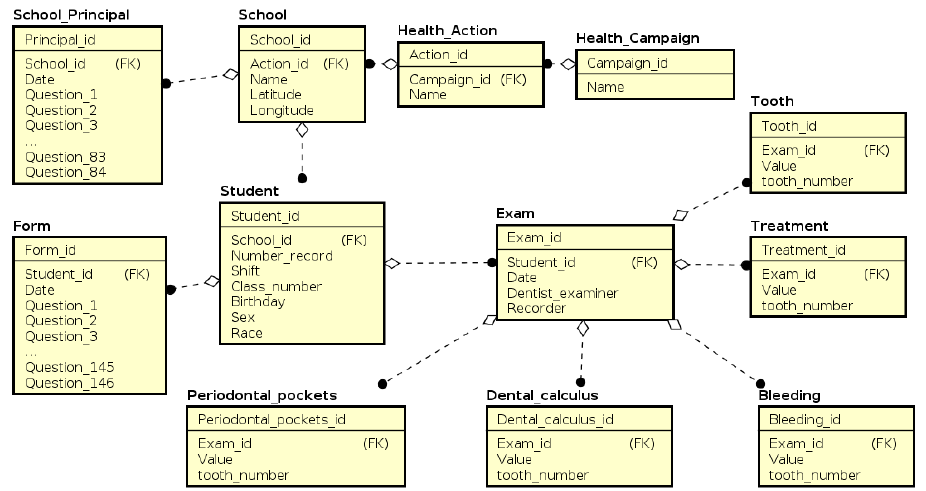
Figure 5. Data structure for storing information collected via the NutriOdonto environment mobile application. Source: Author’s own